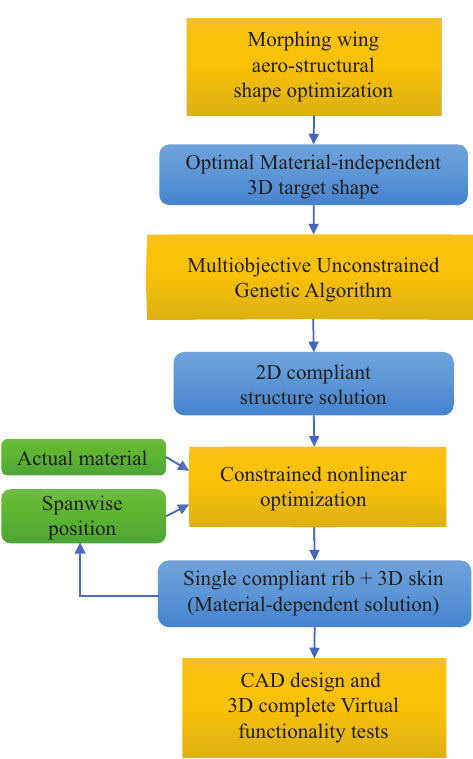
Figure 4. Multilevel optimization